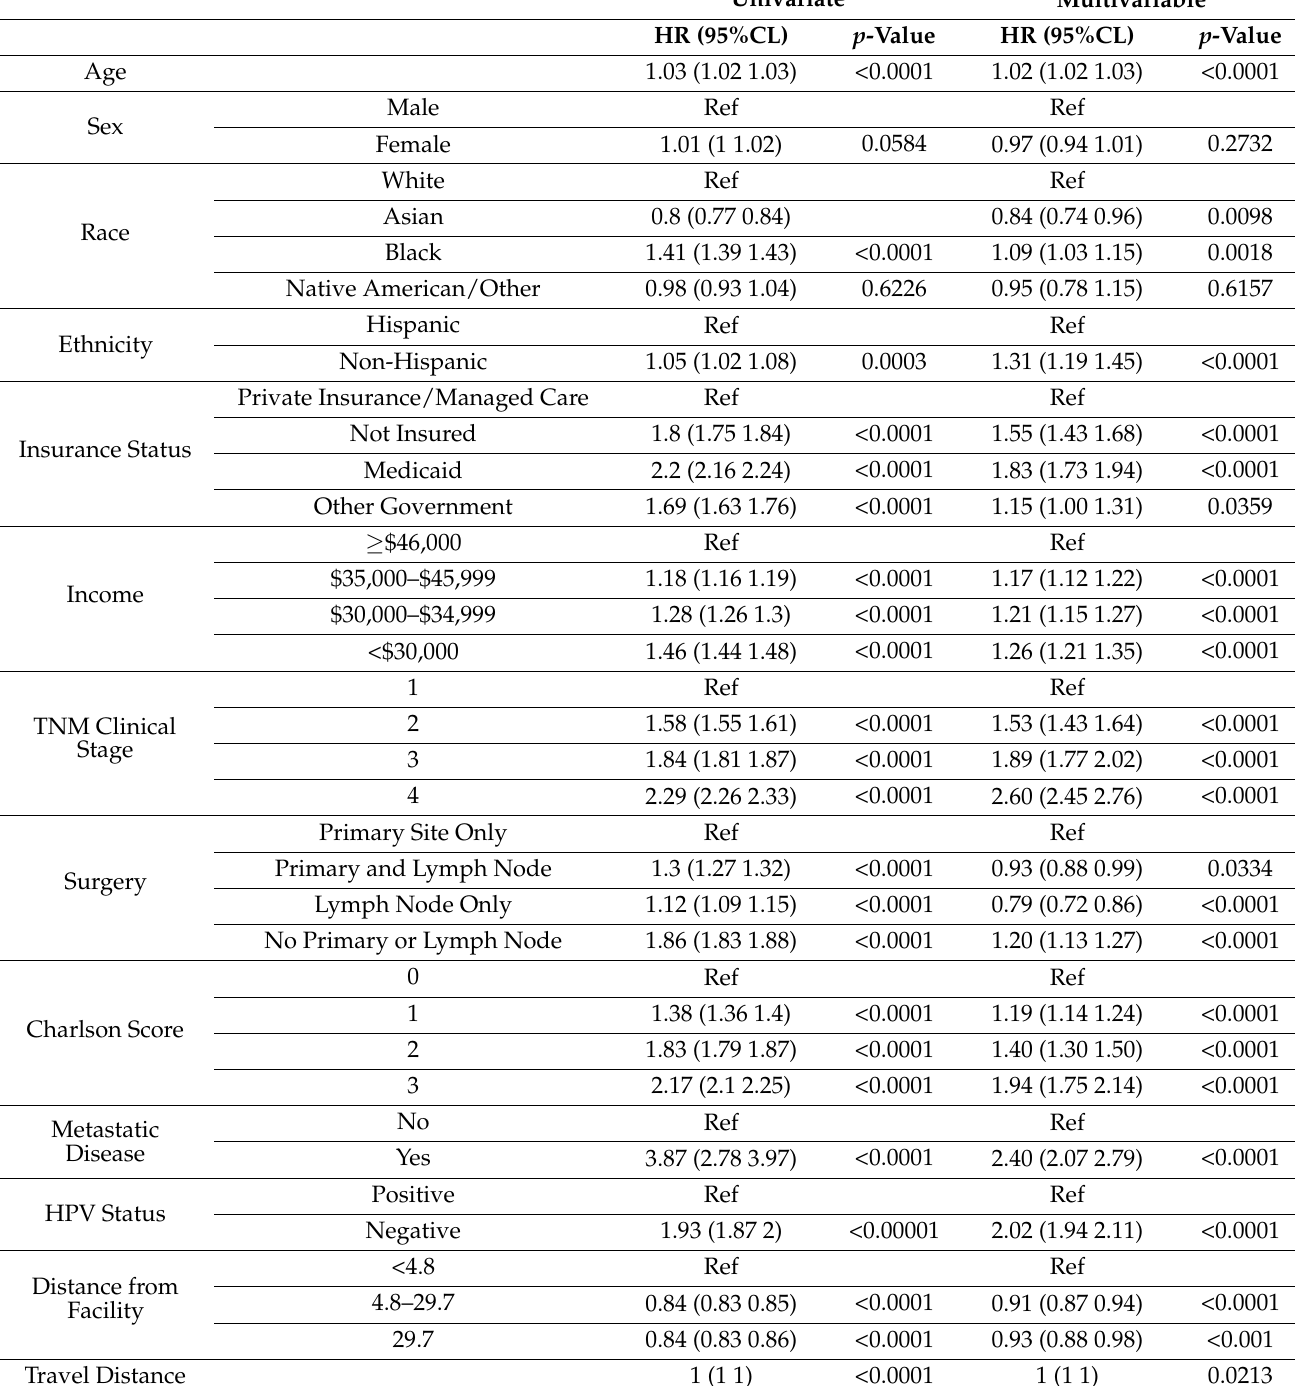
Table 2. Univariate and Multivariate Analyses of Predictors of Survival in Patients with HNSCC. Univariate Multivariable HR (95%CL) p -Value p